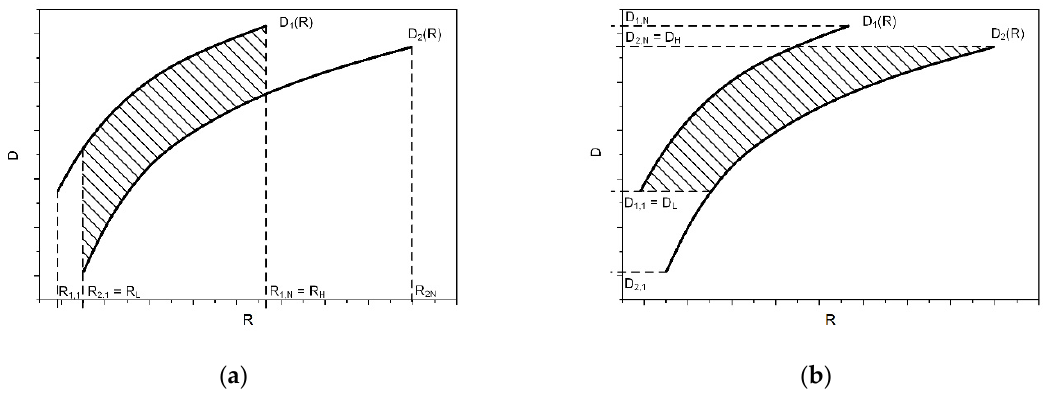
Figure 2. Calculation of the delta distortion ( a ) and delta rate ( b ).